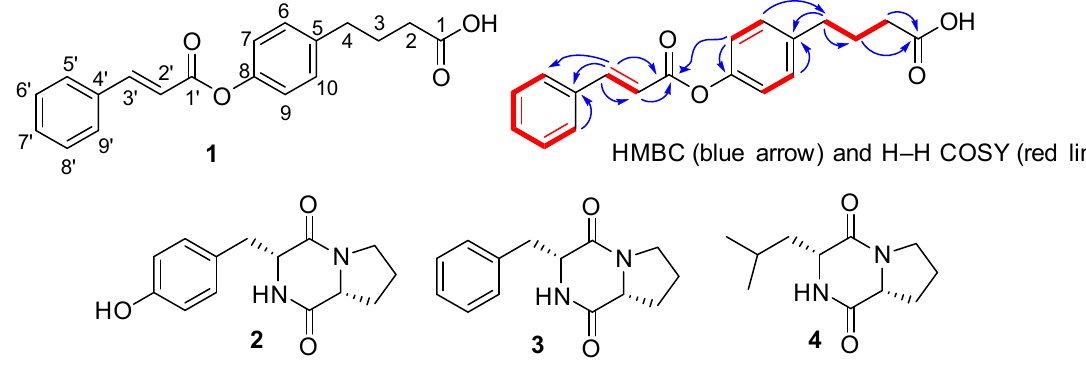
Figure 2. Structure of the new ( 1 ) and known compounds ( 2–4 ) isolated from bacterial strain.